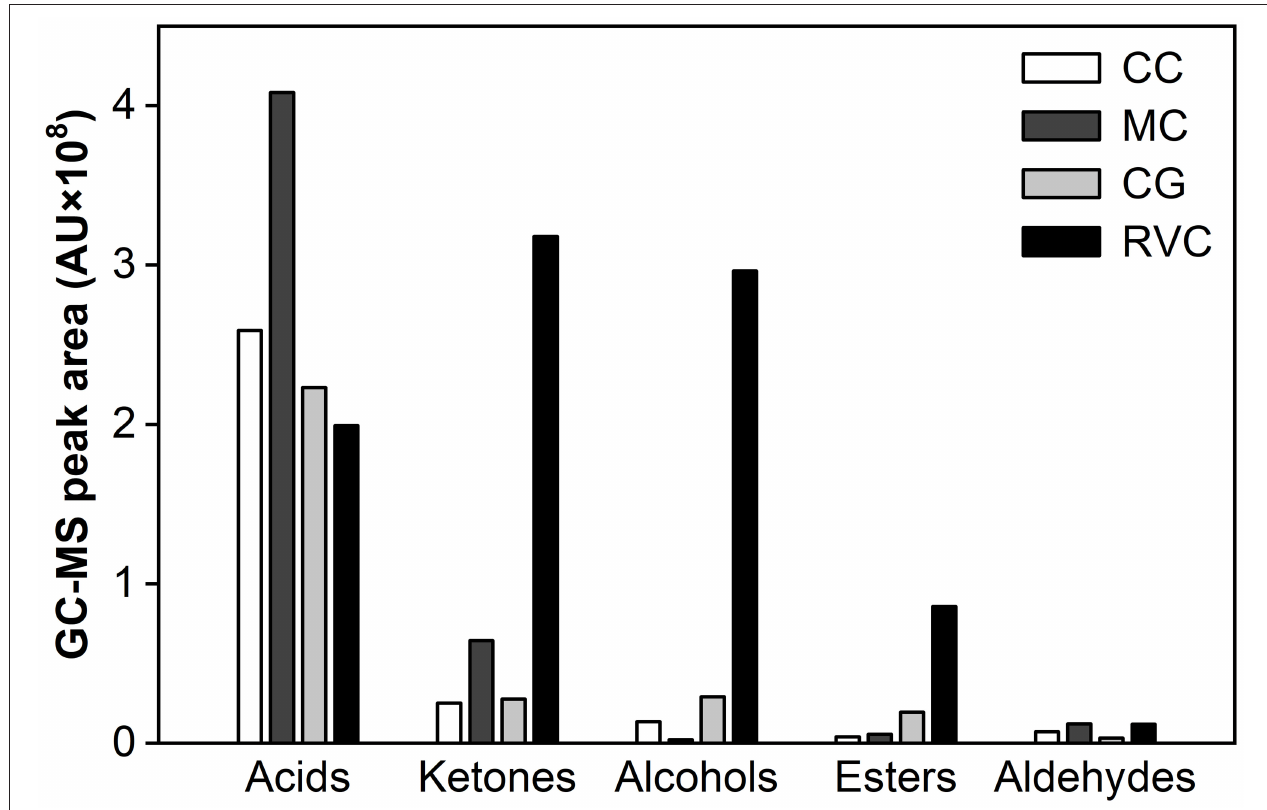
FIGURE 5 | The effects of Monascus -fermentation on the flavor composition of Red-Veined Cheese (RVC) and surface-ripened Monascus -fermented cheese (MC) (8) after 33 days of ripening. CG, control group without inoculation of red koji powder; CC, control group of surface-ripened MC.